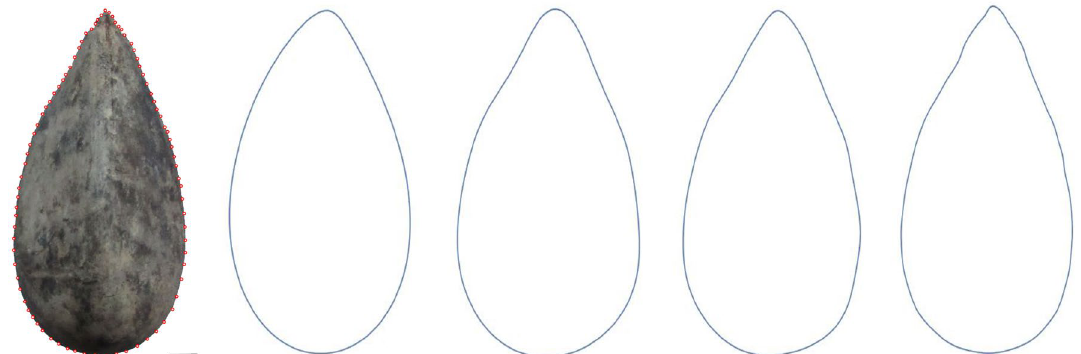
Figure 2. To obtain a Fourier equation corresponding to the silhouette of a seed of Aphandra natalia reference points are taken along the seed profile, and the information related to the coordinates corresponding to the points is transformed into Fourier coefficients. The entire process is done in Mathematica 12.3 ® . From left to right: The seed with points marked (bar equals 0.5 cm) and the curves corresponding to Fourier equations with 2, 6, 10, and 20 harmonics, respectively.